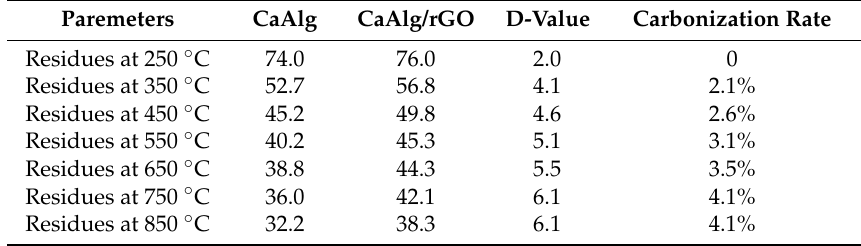
Table 2. Comparison of the weight losses of the CaAlg and CaAlg/rGO materials under N 2 atmosphere over 200 ◦